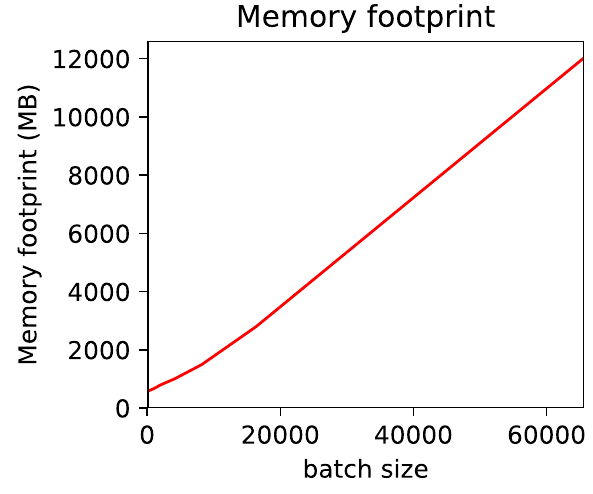
Fig. 4 Memory footprint with different batch